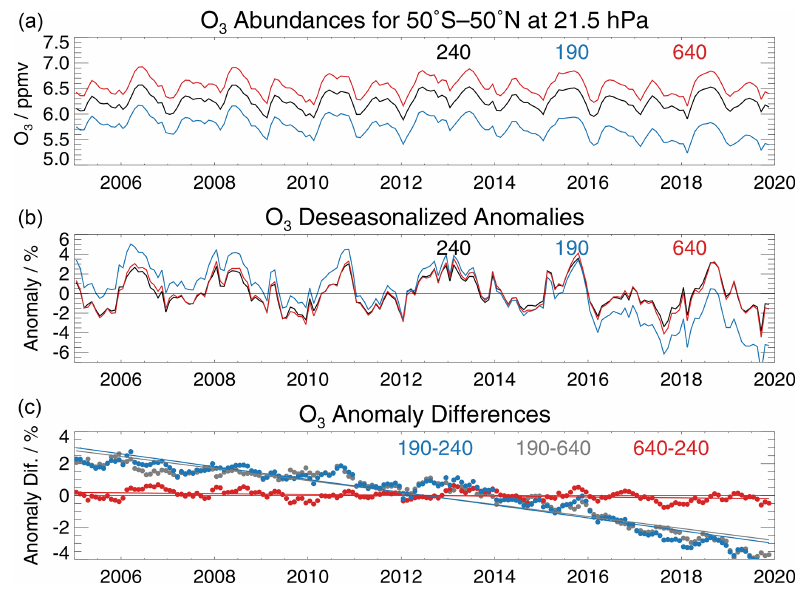
Figure 6. Panel (a) shows a time series of MLS monthly mean ozone measurements from the 190, 240, and 640GHz receivers at 21.5hPa between 50 ◦ S and 50 ◦ N. Panel (b) shows the same time series as deseasonalized anomalies (in %). Panel (c) shows time series of differences between those anomalies for the various combinations of receiver pairs, along with simple linear